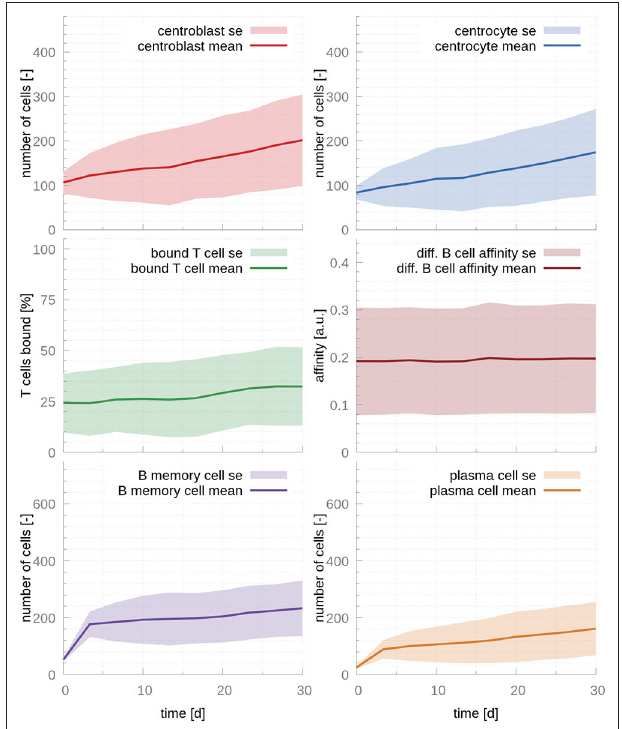
FIGURE 2 | GC cellular populations over time for the set of stabilized literature parameters. The parameters calculated from evidence in the literature, adjusted to lead to stable populations. Affinity does not increase over time, MBC output is still significant at day 30 and PC output only reaches steady state at late time points, contrarily to experimental evidence ( 17). The ratio of T cells interacting with B cells never exceeds 35%, which results in insufficient competition for T cell help. In the figures above, germinal center cell counts are the average number of concurrent cells, while cells leaving the germinal center are accumulated per periods of 18 h. The shaded area depicts standard error